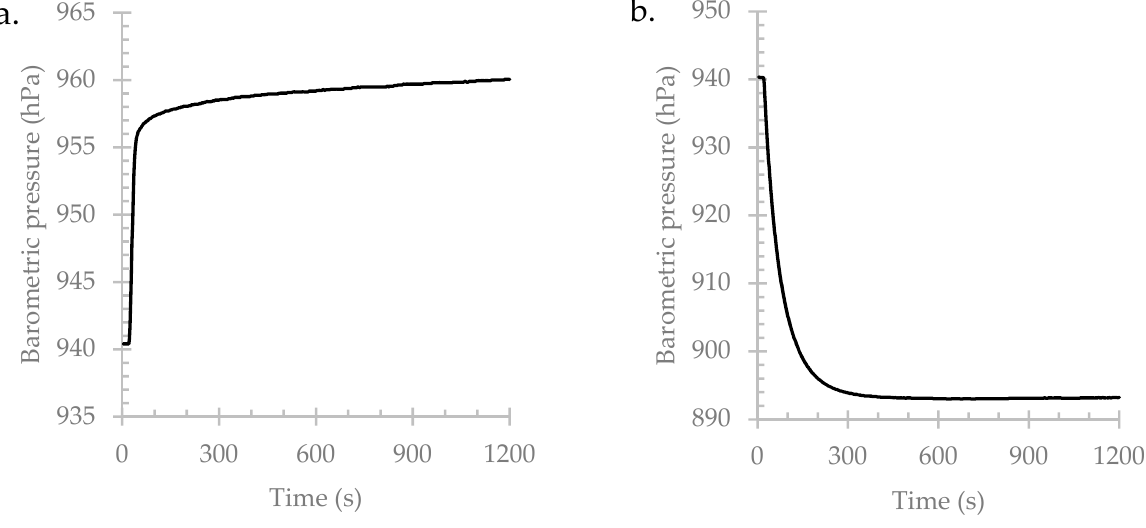
Figure 8. Limits of pressure (hPa) inside the chamber: ( a ) maximum positive pressure; ( b ) maximum vacuum. Lines indicate the maximum variation in barometric pressure that can be achieve while pressurizing and depressurizing the chamber in its current setup.